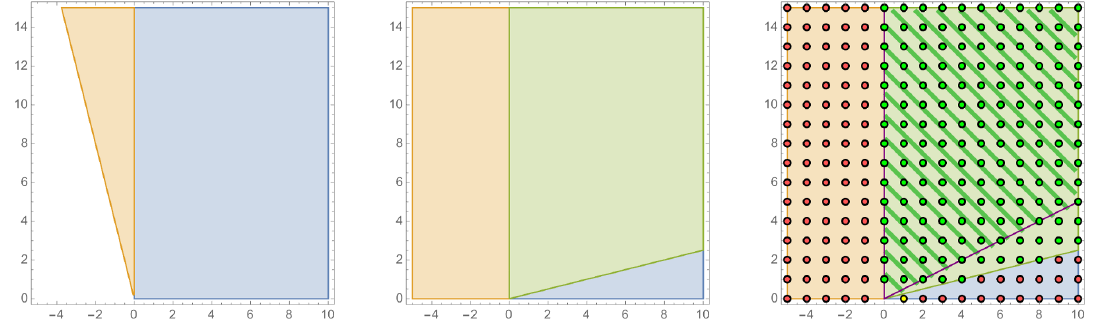
Figure 1 . Kähler and Mori cone for CICY 7887. Left : Kähler cones K (blue) and K 0 (orange). The extended cone is K ext = K∪K 0 . Center : the (dual) Mori cones M of K (blue and green) and M 0 of K 0 (orange and green). Note that the cones overlap in the restricted cone M restr = M∩M 0 (green). Right : similar to the center figure, but we have included the GV invariants as dots. Green dots indicate non-zero GV invariants, red dots indicate zero GV invariants, and yellow dots indicate (non-zero) GV invariants in curve classes that are flopped. A choice for the fundamental cone M f ⊂ M restr is the hatched region between the two purple